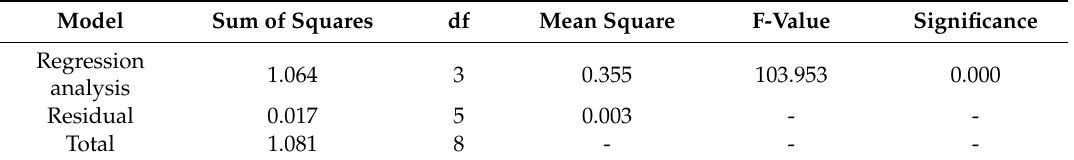
Table 6. ANOVA analysis results of the multiple regression model.